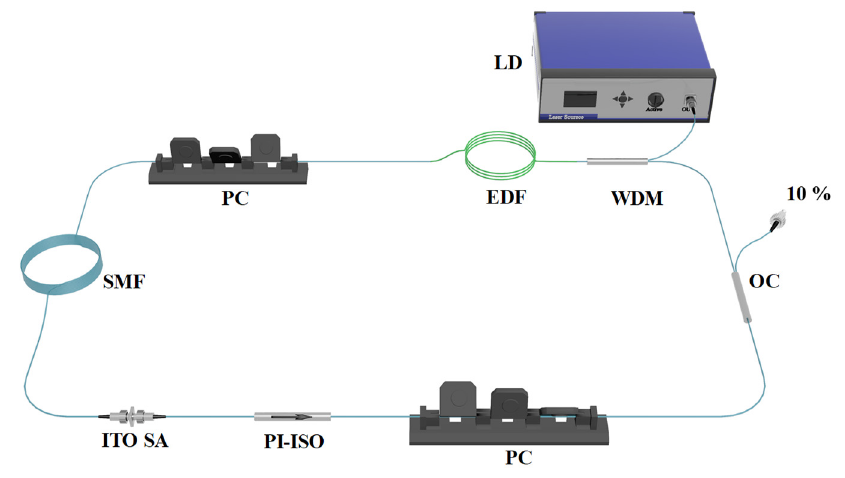
Figure 4. Schematic of the pulsed fiber laser including the ITO film saturable absorber (SA).